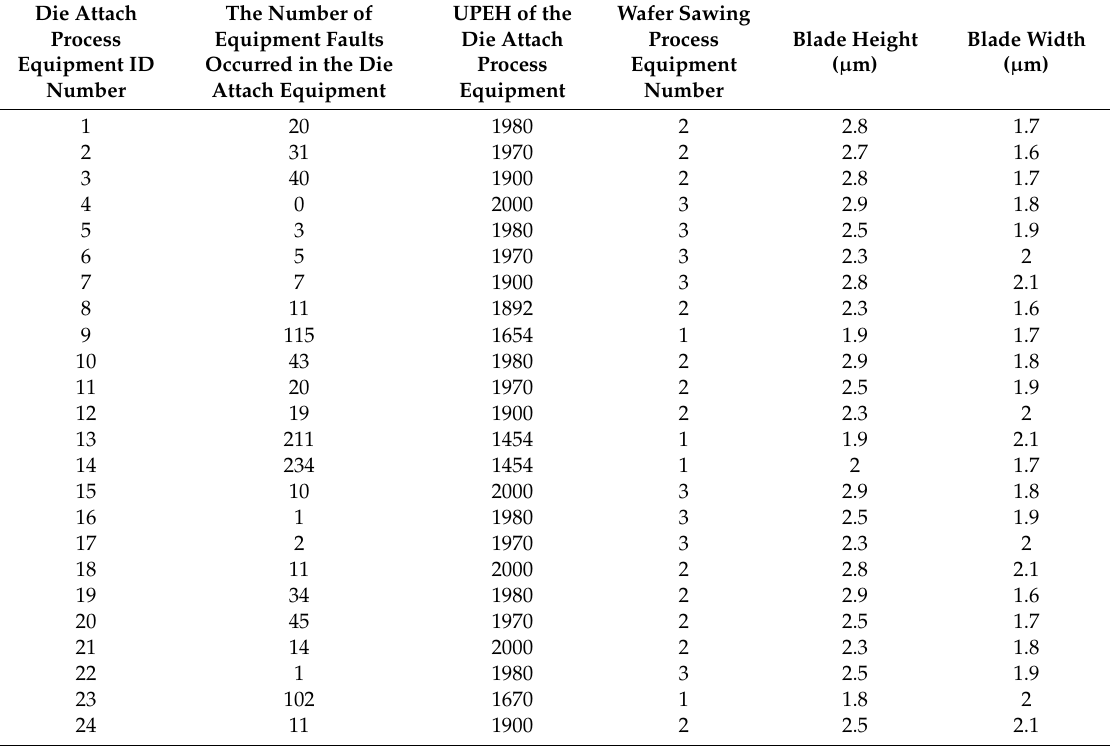
Table 6. The die attach equipment data and the wafer sawing process equipment